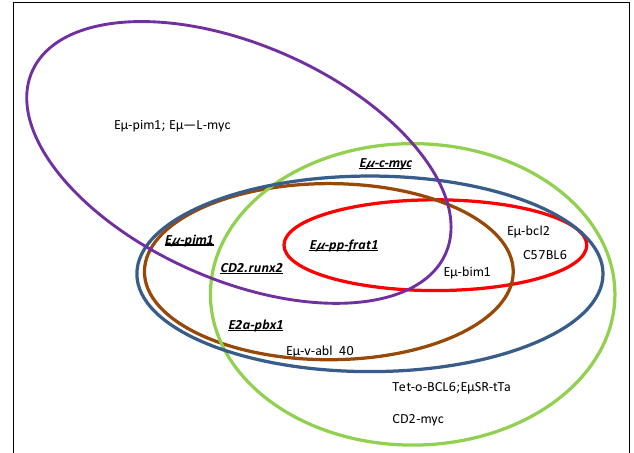
FIGURE 1 |Which genes and proviral insertion sites cooperate with Pim1? In different mouse models, pim1 (green ellipse), pim2 (red ellipse), c-myc (blue ellipse), N-myc (brown ellipse) and Pal1/gfl1 (purple ellipse) are the more frequent proviral insertion sites in M-MuLV infection.The cooperation between Pim1 and some of these other genes has also been confirmed by bitransgenic mouse models (underlined and